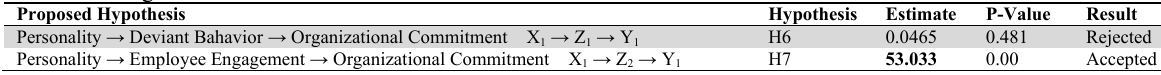
Indirect Testing of Path Coefficients Proposed Hypothesis